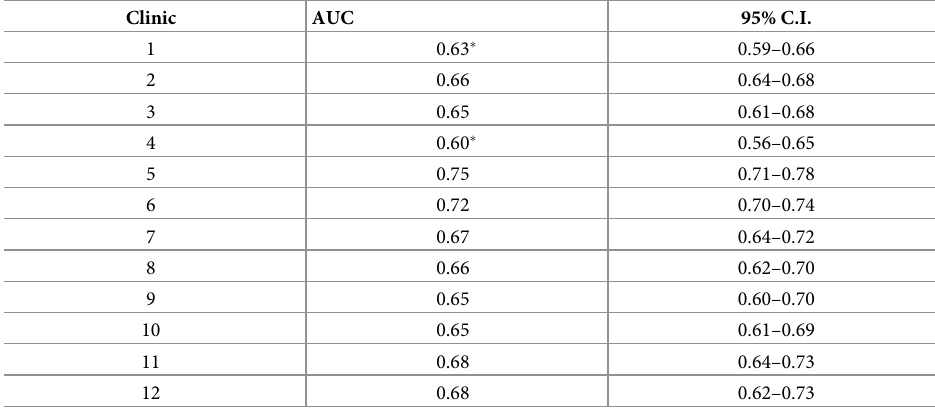
Table 4. The area under the curve (AUC) and 95% Confidence Interval (C.I.) in the clinic hold-out test for embryos with known outcome (KID).